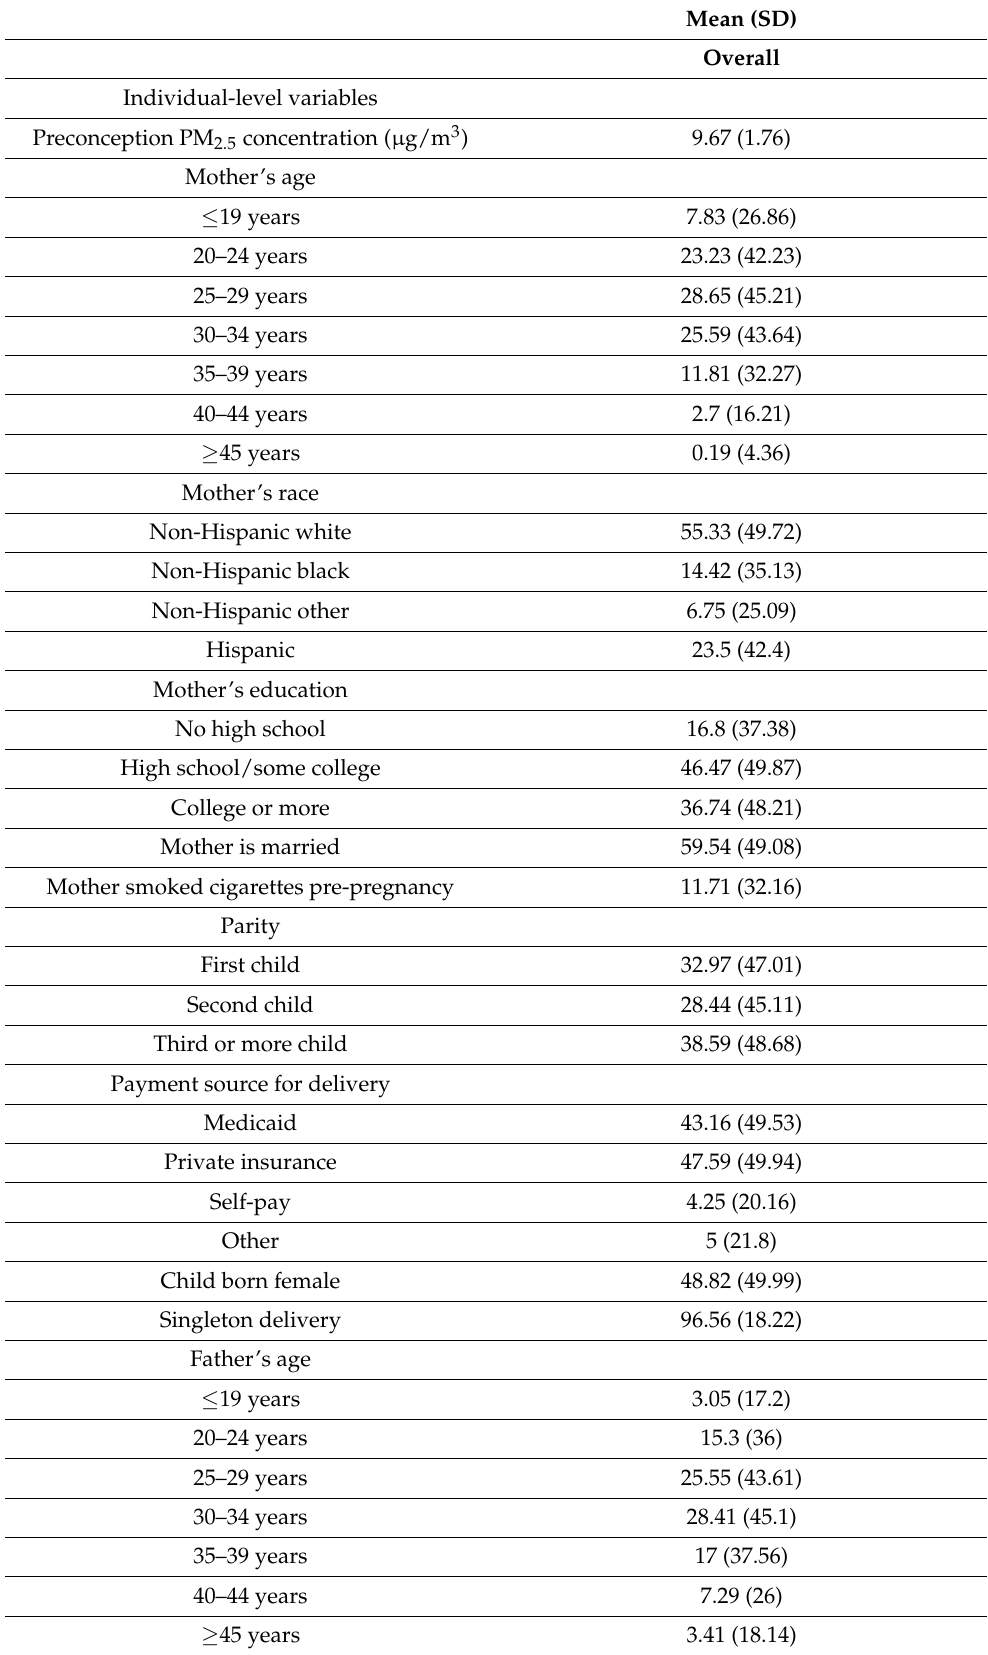
Table 1. Distribution of individual, delivery, and county-level covariates in the analytic